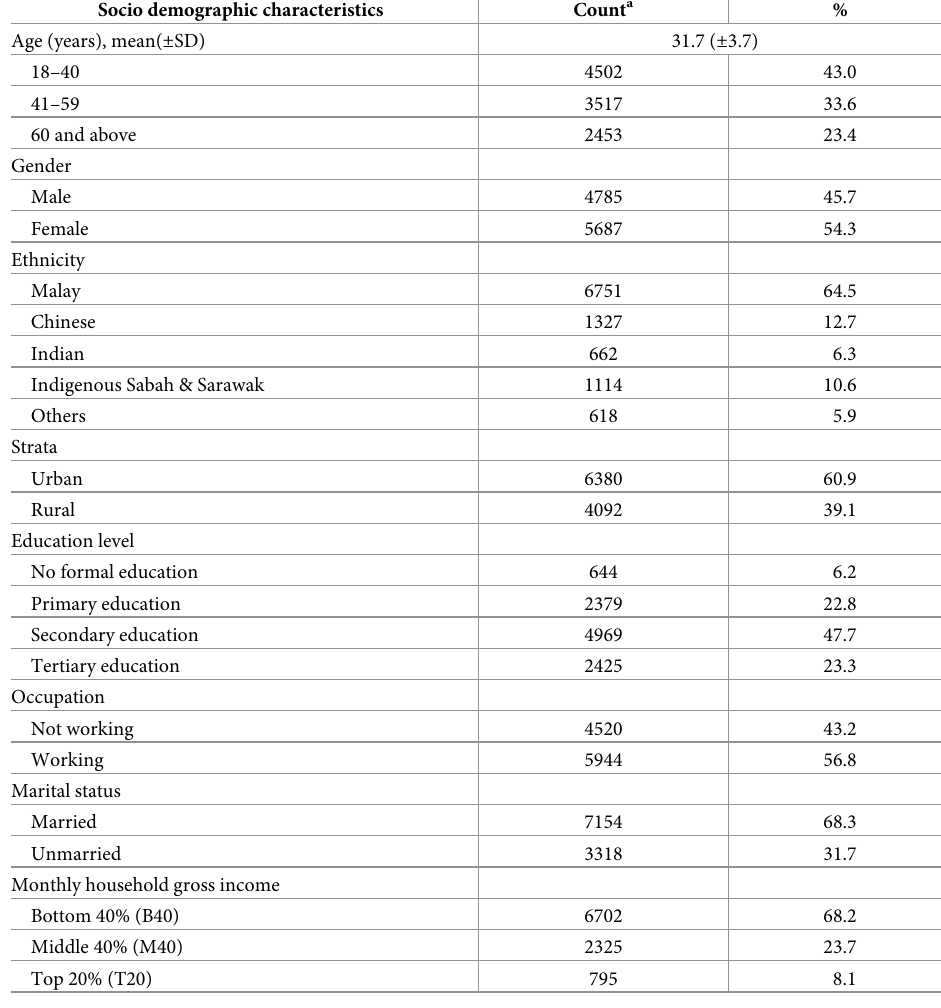
Table 1. Socio demographic characteristic of participants (n =